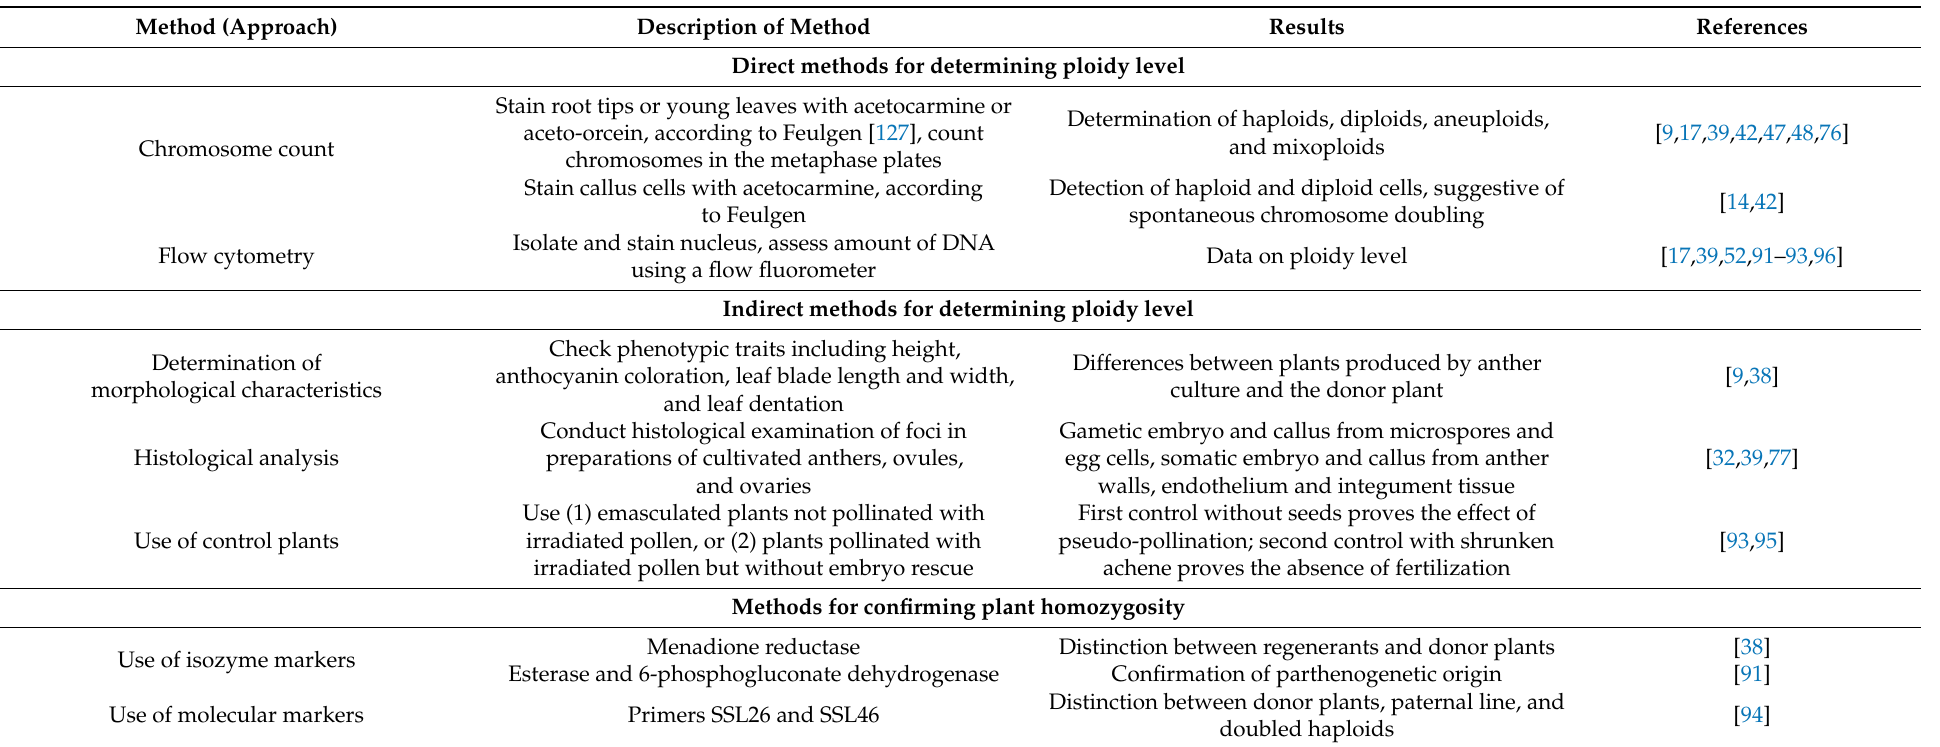
Table 4. Methods for determining the ploidy level and confirming the homozygosity of